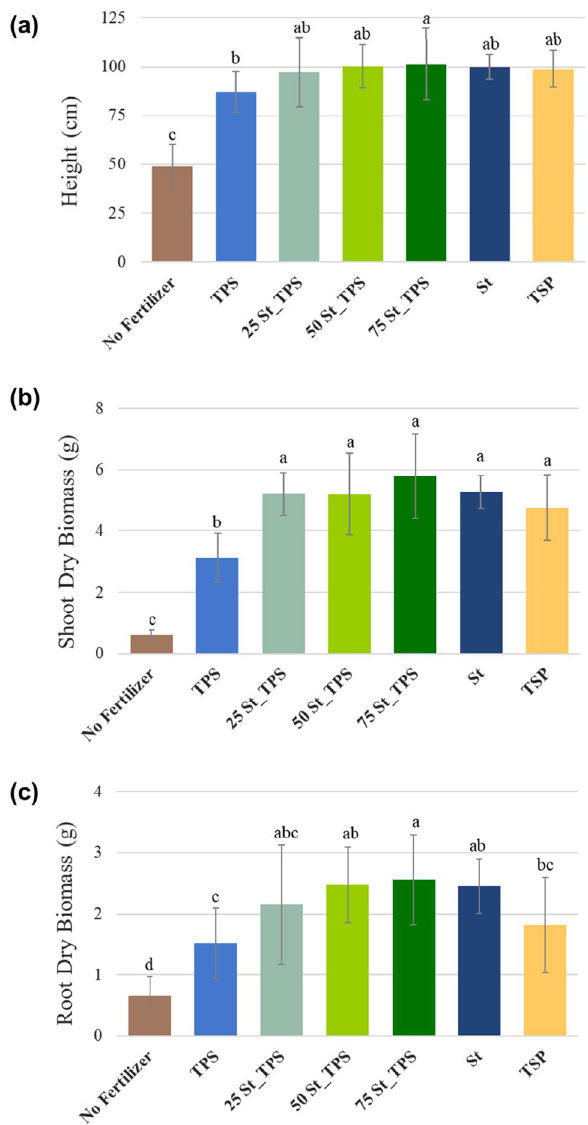
Figure 7. Average ( a ) plant height and dry biomass of ( b ) shoots and ( c ) roots achieved after 42 days of maize cultivation. Bars show mean values ± standard deviations (n = 16 for plant height, n = 15 for shoot biomass, and n = 17 for root biomass). Indexes a, b, c, and d represent the statistical differences between treatments ( p < 0.05).